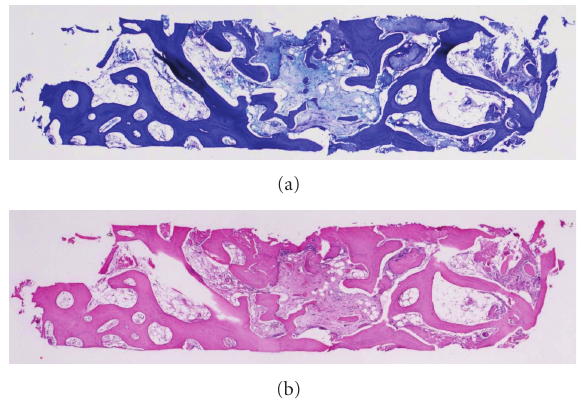
Figure 4: Good bone regeneration was observed, with an average mature bone formation rate of 36.3 ± 16.5%. (a) Stained with toluidine blue; (b) stained with H&E.